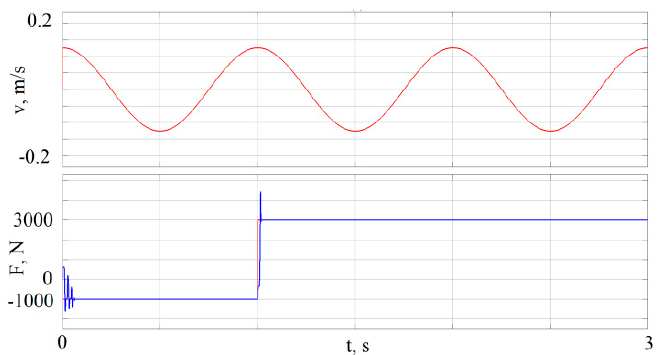
Figure 14. Desired force as a step. Top: velocity of the rod; bottom: force on the rod (red—desired, blue—actual).